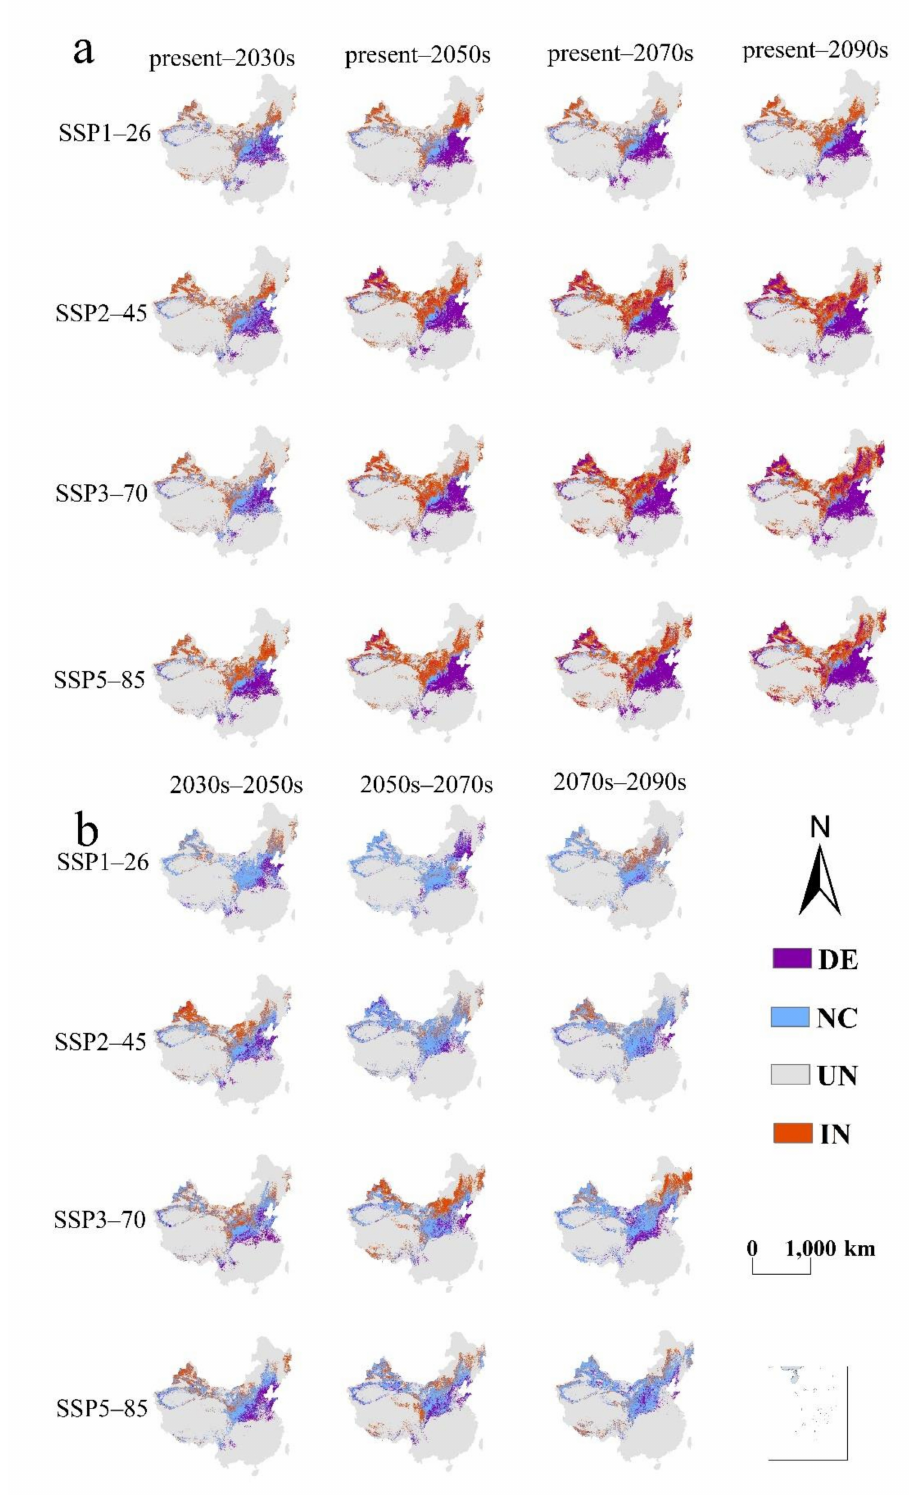
Figure 6. Change in suitability of Valsa mali under four future climate scenarios (the Shared Socioeconomic Pathways (SSP) 1–26, SSP2–45, SSP3–70, and SSP5–85): future–present intervals ( a ) and 20–year equal intervals ( b ). The formulas with “–” represent the intervals which are used to calculate the suitability changes (i.e., 2030s–2050s represent the period from the 2030s to the 2050s). The DE, NC, UN, and IN represent decrease, no–change, unsuitable, and increase in suitability of V. mali